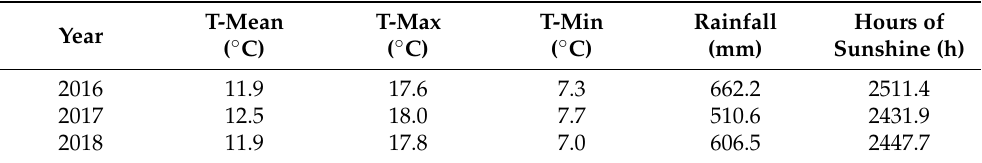
Table 2. Climatic conditions during the whole growing season of apples in 2016–2018 for Beiquan Village, Hebei, China. T-Mean T-Max T-Min Rainfall Year ( ◦ C) ( ◦ C) ( ◦ C) (mm)